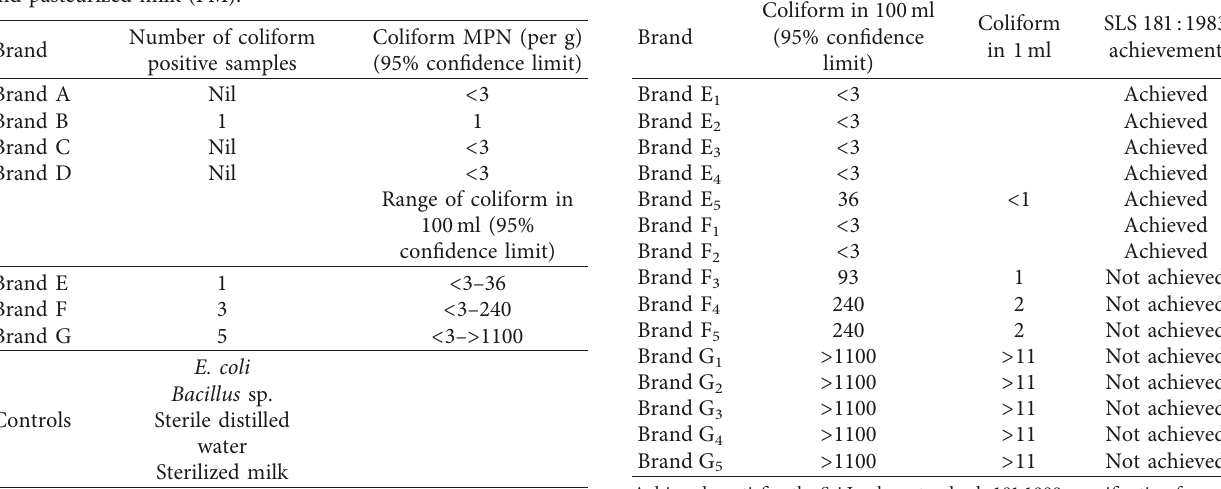
Table 4: Total coliform count in full cream milk powder (FCMP) and pasteurized milk (PM).